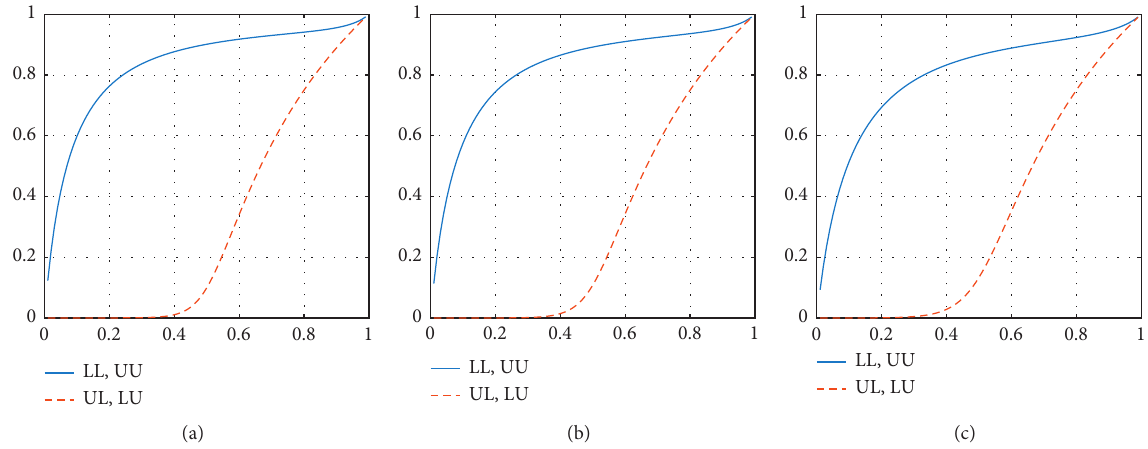
Figure 12: QD curves of bivariate Frank copula model. (a) HSI-CEI. (b) HSI-CCI. (c) CEI-CCI.